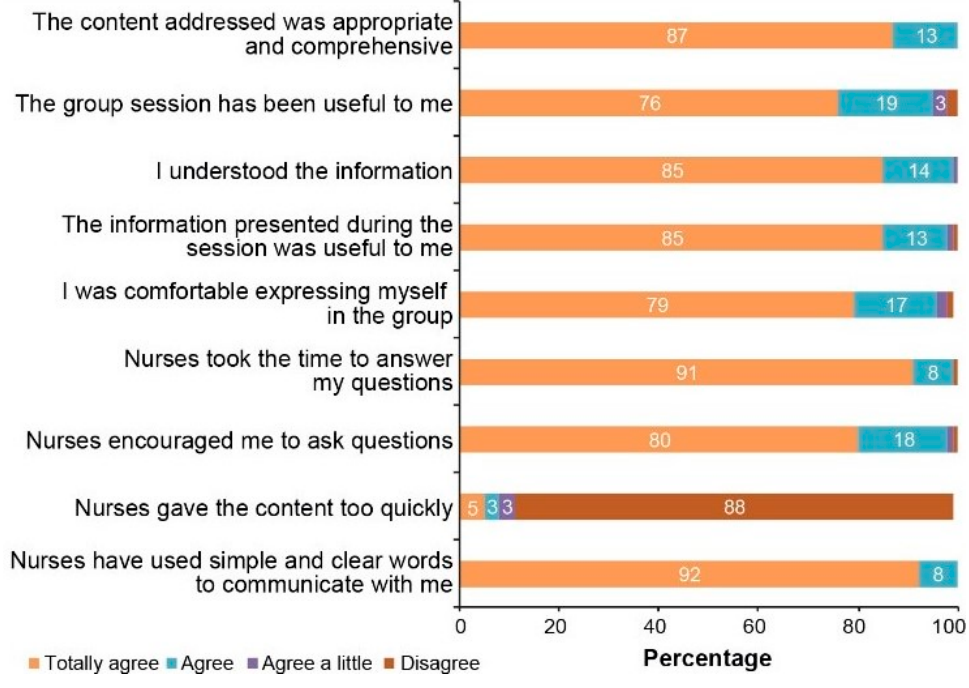
Figure 4. Satisfaction with Group Genetic Counseling.